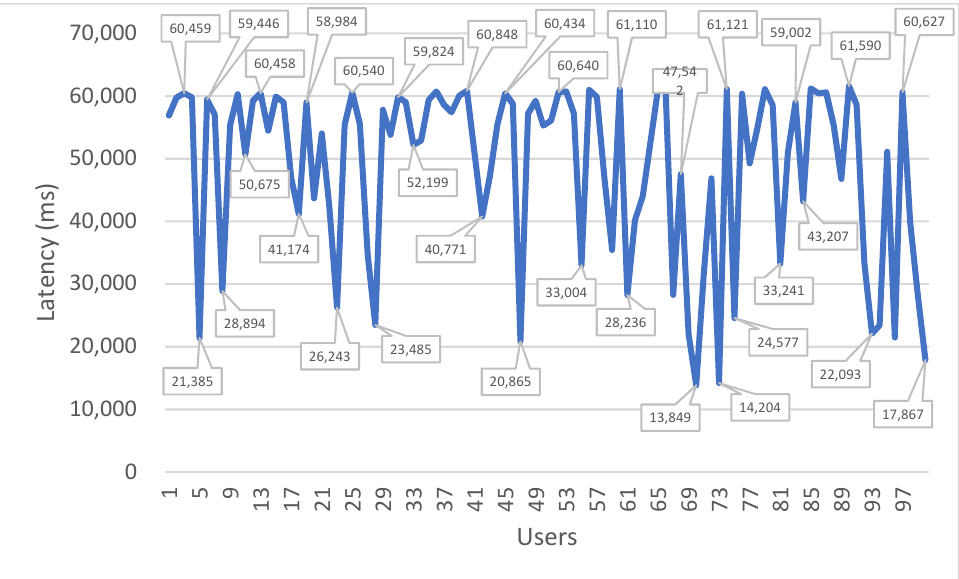
Figure 6. Latency time versus number of users.